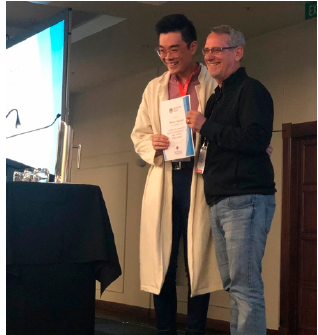
Figure 4. Wilson Nguyen ( left ) receiving the AVS10 Poster Video Award presented by Professor Paul Young ( right ).